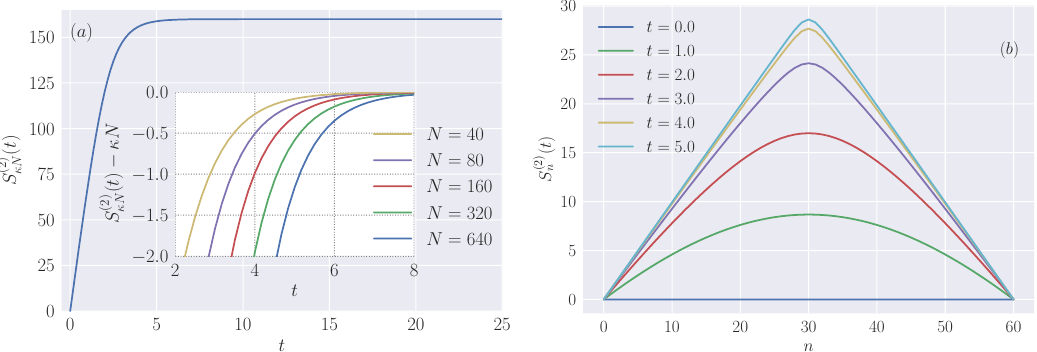
Figure 2 . R(cid:19)enyi entropy dynamics for di(cid:11)erent subsystems, obtained by solving eq. (3.19) with (cid:21) 2 = 0 (no coupling with the environment), (cid:21) 1 = 1 and local dimension d = 2. Sub(cid:12)gure ( a ), main panel: R(cid:19)enyi-2 entropy S (2) ( t ) as a function of time, for N = 640 and (cid:20) = 1 = 4. Inset: the plot (cid:20)N shows the di(cid:11)erence between S (2) ( t ) and its maximum possible value (cid:20)N as a function of time and (cid:20)N for increasing system sizes N . Denoting by t (cid:3) the amount of time needed before ( (cid:20)N ) becomes larger than a small negative constant " (cf. the main text), it is clear from the plot that t (cid:3) ln( N ). Sub(cid:12)gure ( b ): R(cid:19)enyi-2 entropy S (2) n ( t ) as a function of the subsystem size n , for ( (cid:20)N ) (cid:24) di(cid:11)erent